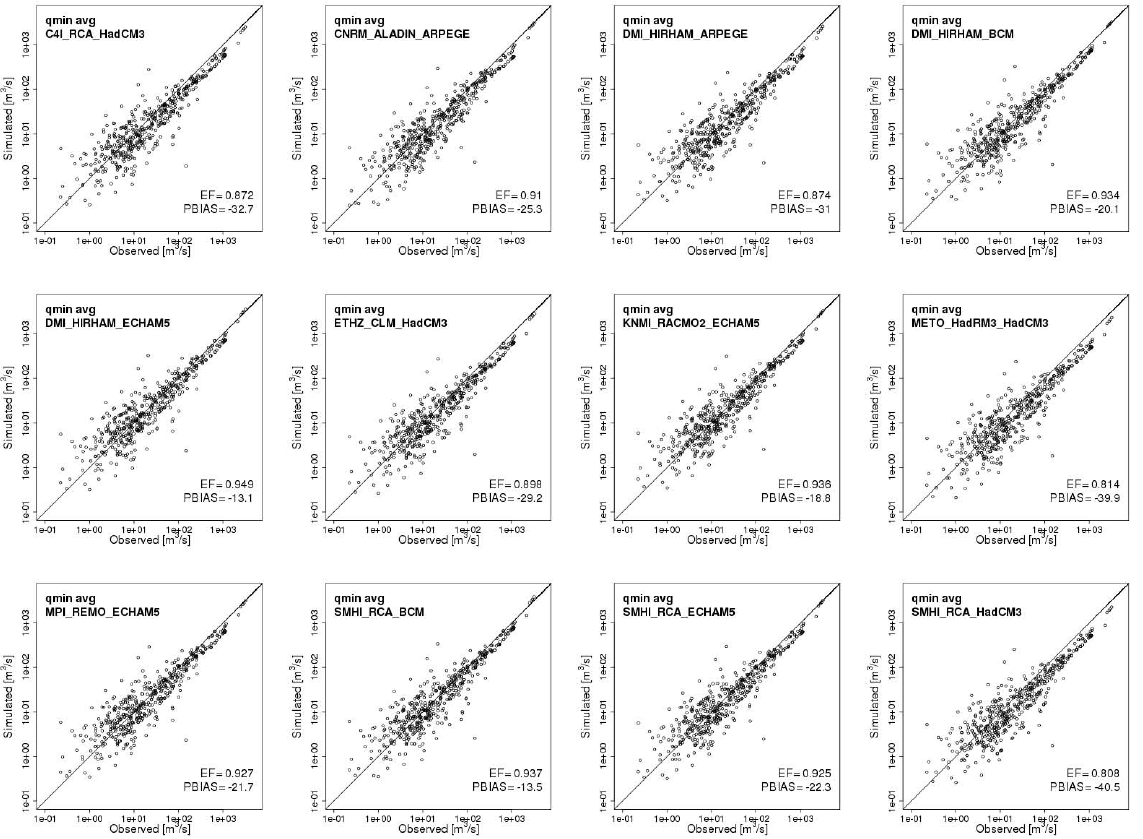
Fig. 2. Observed versus simulated average annual 7 day minimum flows for the control period (1961–1990) at each of the 446 stations depicted in Fig. 1 based on the hydrological simulations driven by the 12 climate experiments listed in Table 1.